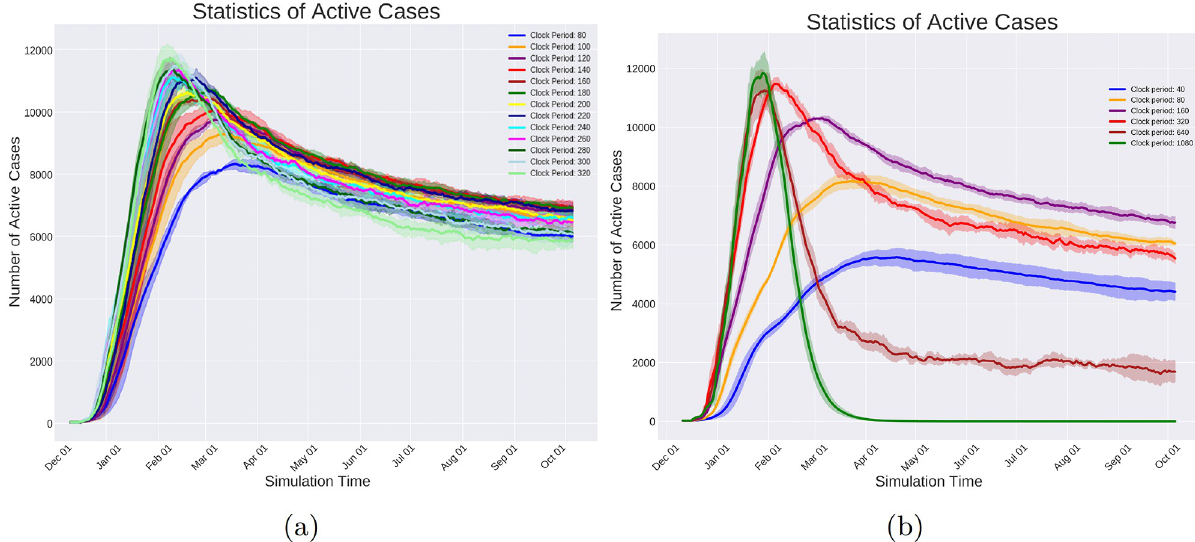
Fig 9. Experiments demonstrated here are focused on the almost invariant behavior of the simulator within a reasonable chance of the temporal resolution either when applying various control policies or by changing the spread period. The population structure and other details related to these experiments are the same as Section 2.1, with a population size of 20k people. (a) Shows this consistency for clock periods in the interval [80, 320], whereas (b) suggests that the reducibility of the system is a barrier that breaks this invariance feature in case of a radical reduction of temporal